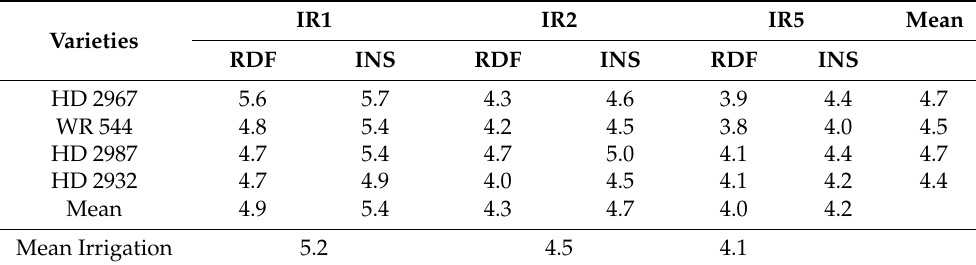
Table 1. Interaction effect of irrigations schedules, nutrient levels, and varieties on root volume (cm − 3 ) at 50% flowering